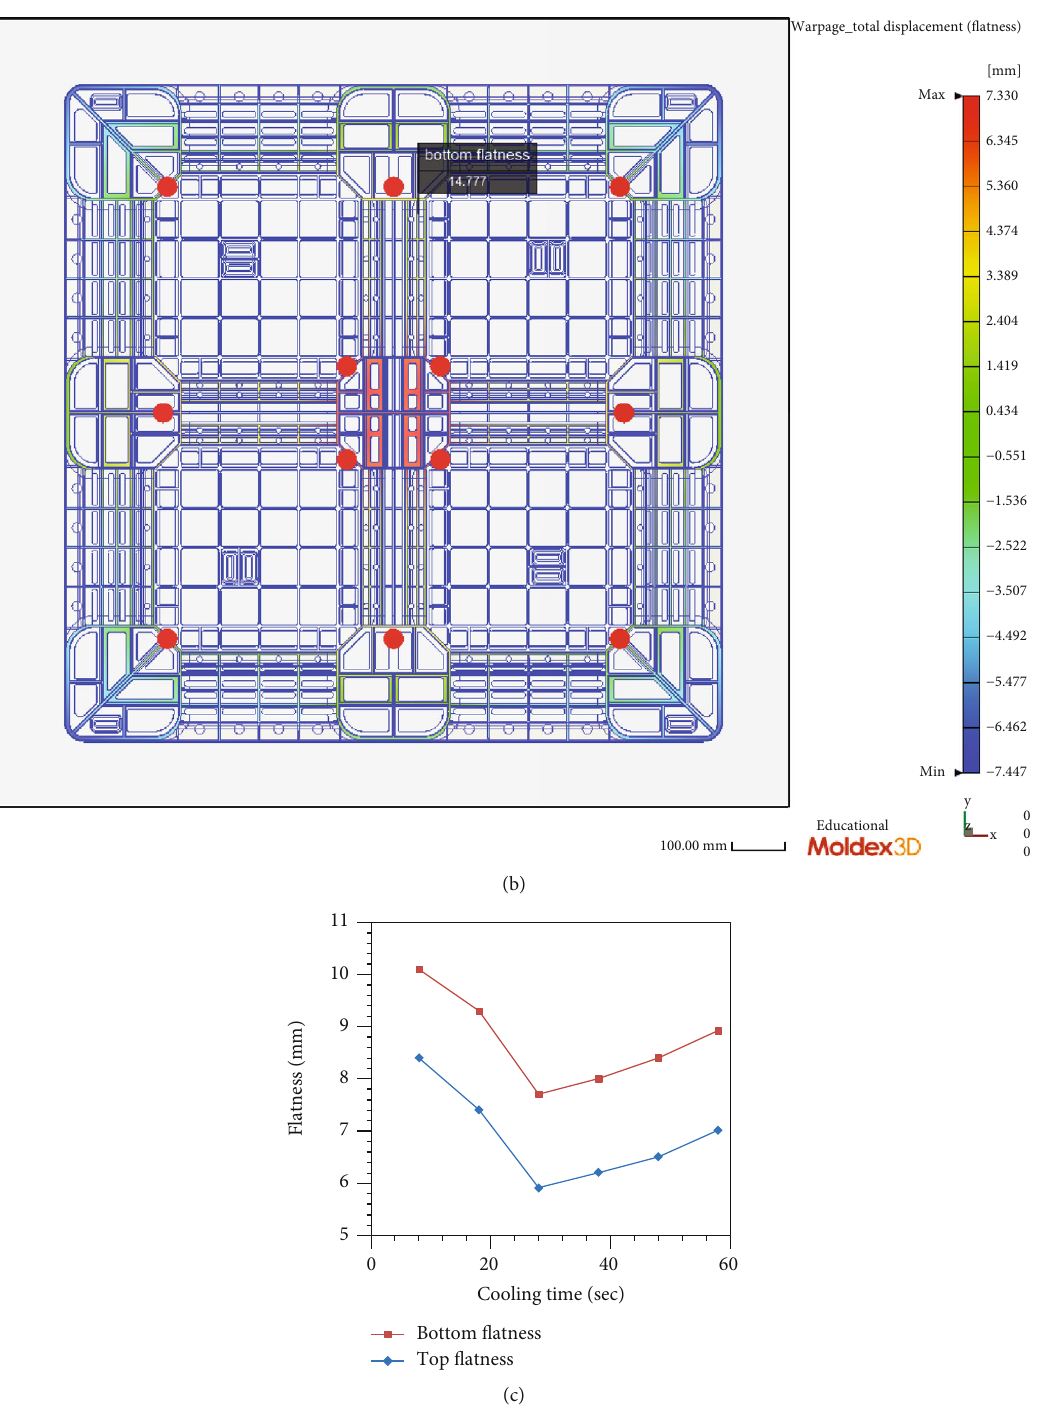
Figure 13: Flatness of the pallet. (a) The fl atness of the top plane of the pallet (cooling time 48sec, mold temperature 40 ° Celsius, cooling channel 20 ° Celsus) ( fl atness 12.433 mm). (b) The fl atness of the bottom plane of the pallet (cooling time 48 sec, mold temperature 40 ° Celsius, cooling channel 20 ° Celsius) ( fl atness 14.777mm). (c) Flatness with respect to cooling time under mold temperature 40 ° Celsius, cooling channel 60 °